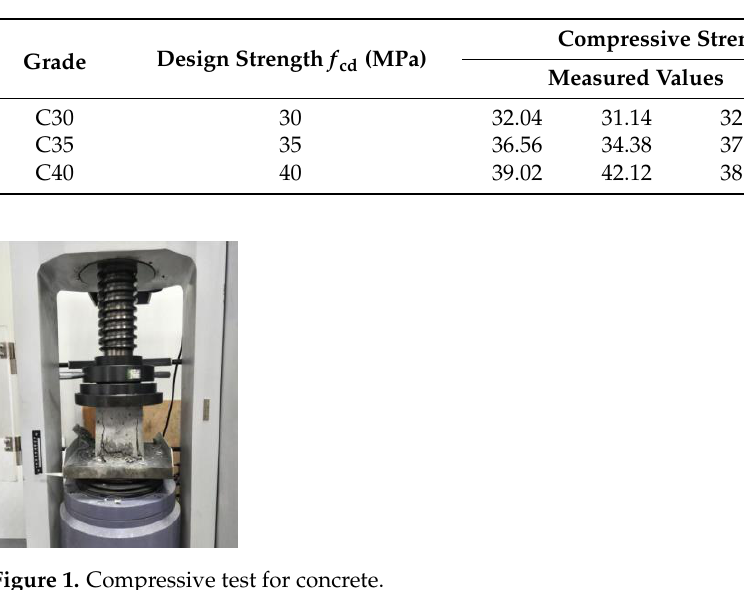
Table 2. Material properties of concrete.